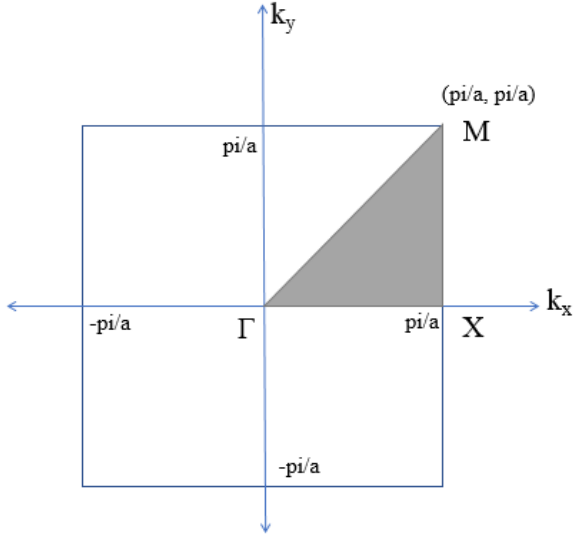
Figure 5. Schematic of the Brillouin zone for 2D